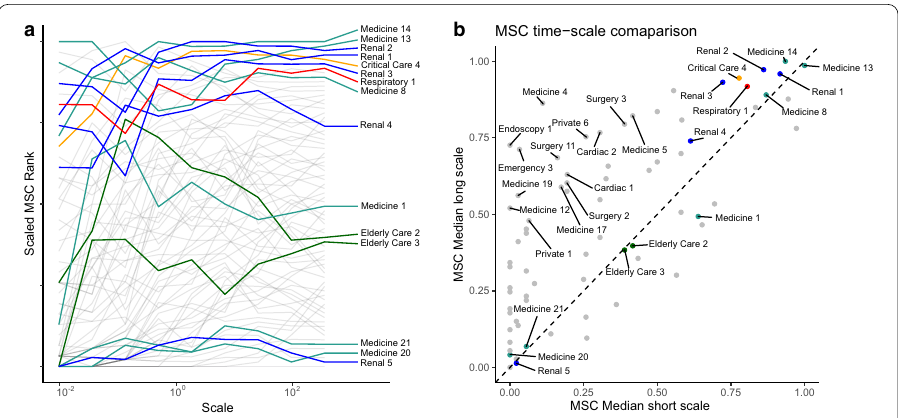
Fig. 7 Ranking of nodes by their multiscale centralities (MSC) in ˆ M 2 . a Multiscale centrality ward rankings across all scales; all wards are plotted (light grey lines) with highlighted wards in colour. A high value of the scaled MSC Rank means that the wards are important. b A comparison of the MSC ranking at short scales versus long scales. The annotated wards are those with large differences in their PageRank in M 1 versus M 2 . Note that at short scales, some nodes will have not been assigned a Multiscale centrality value and so share the bottom